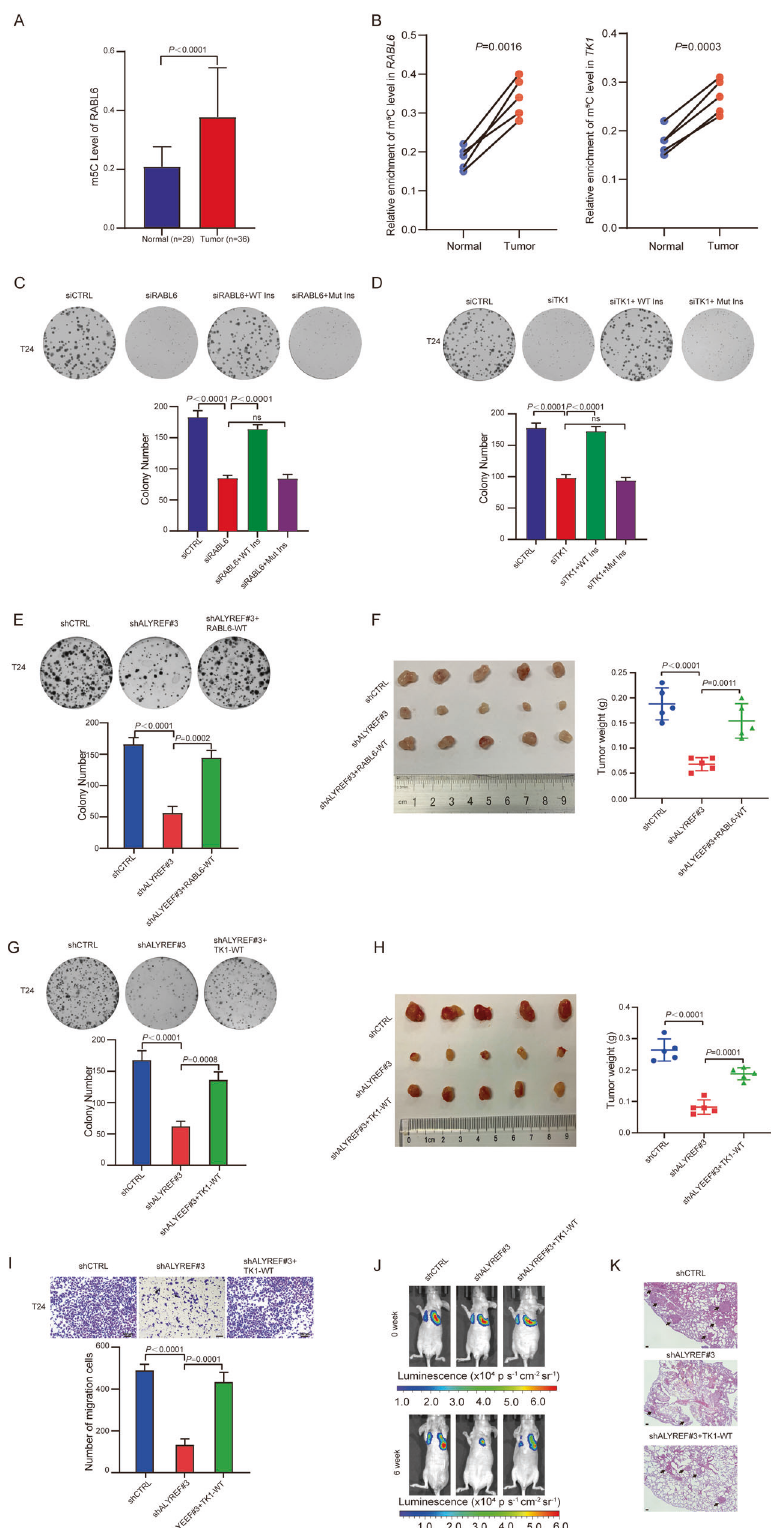
ALYREF recognizes hypermethylated m 5 C site of NSUN2 , resulting in NSUN2 upregulation in UCB From our previous RNA-BisSeq data in T24 cell, we identi fi ed an m 5 C methylation site located in the 3 ′ UTR of NSUN2 (chr5: